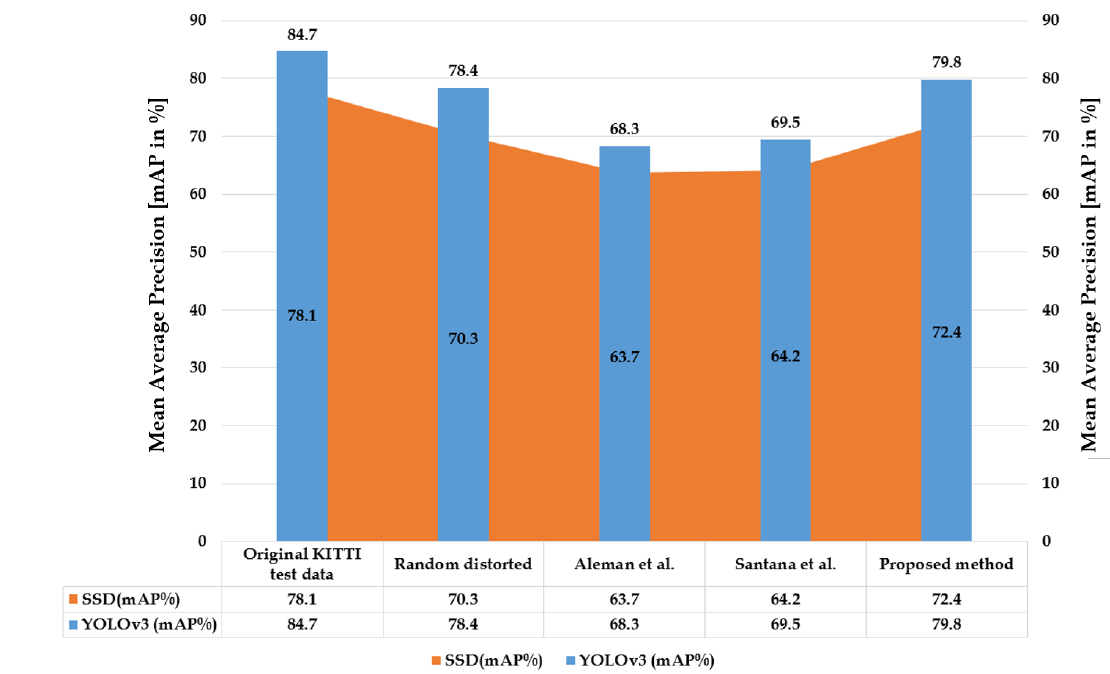
Figure 16. SOTA pretrained YOLOv3 and SSD were employed to detect the objects in the scene on distorted KITTI samples rectified with various